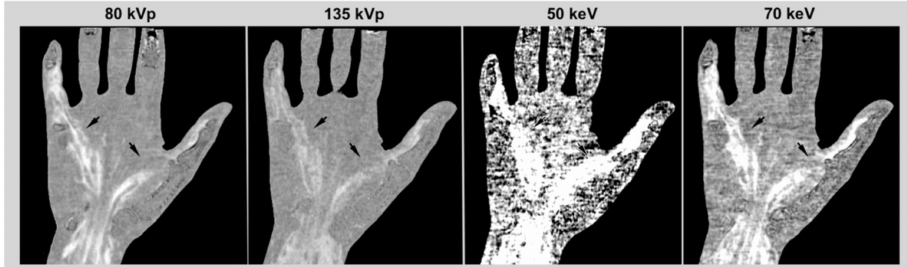
Figure 1. Examples of grayscale CT subtractions with conventional 80 and 135 kVp images and 50 and 70 keV monochromatic images. Images are presented with WL/WW of 0/300. While high-energy datasets (135 kVp) showed low noise and contrast, the contrast increases with lower energy and for monochromatic